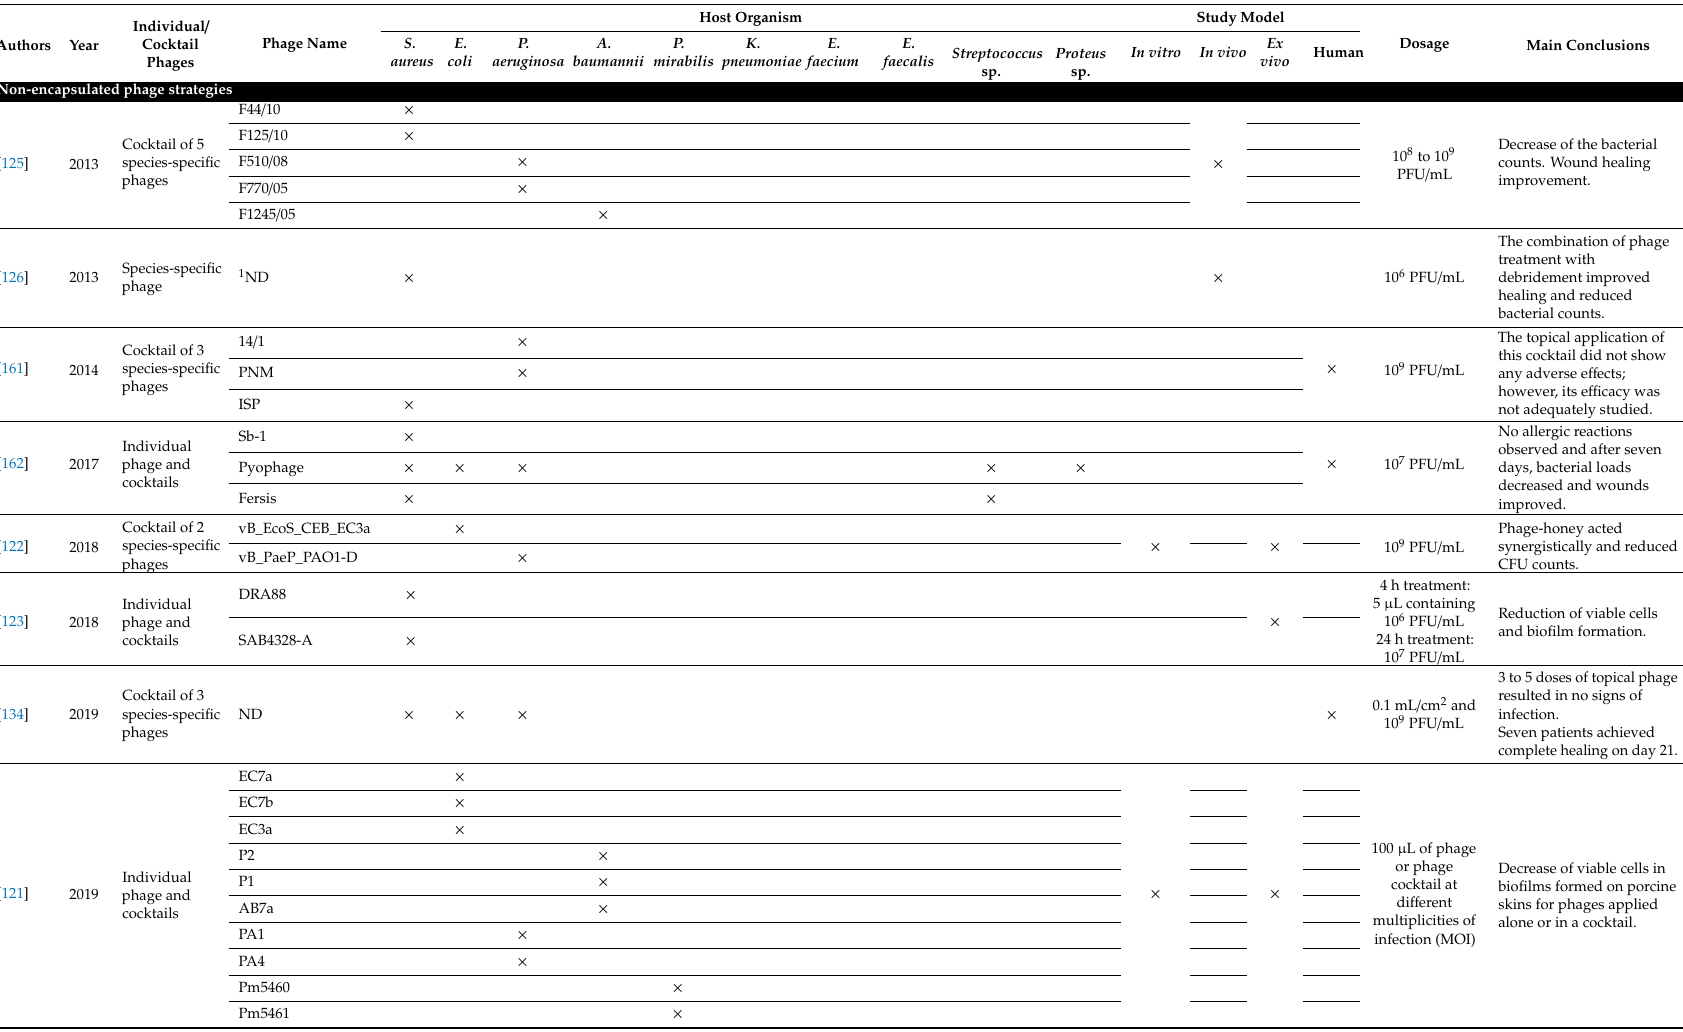
Table 1. Di ff erent phage therapy approaches reported using in vitro , ex vivo , and in vivo animal and human models of chronic